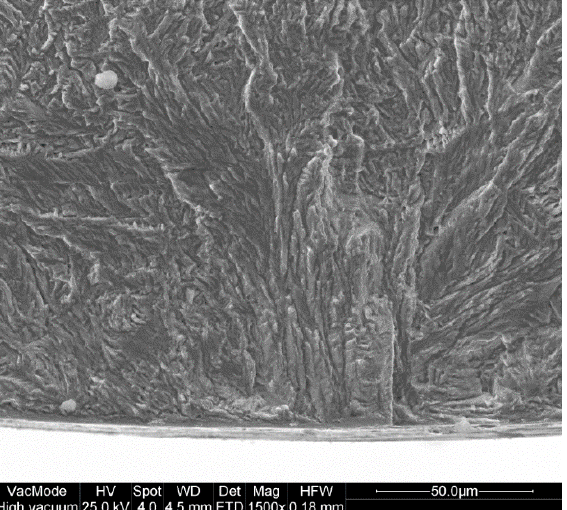
6 ). a = 540 MPa, N f = 1.36 × 10